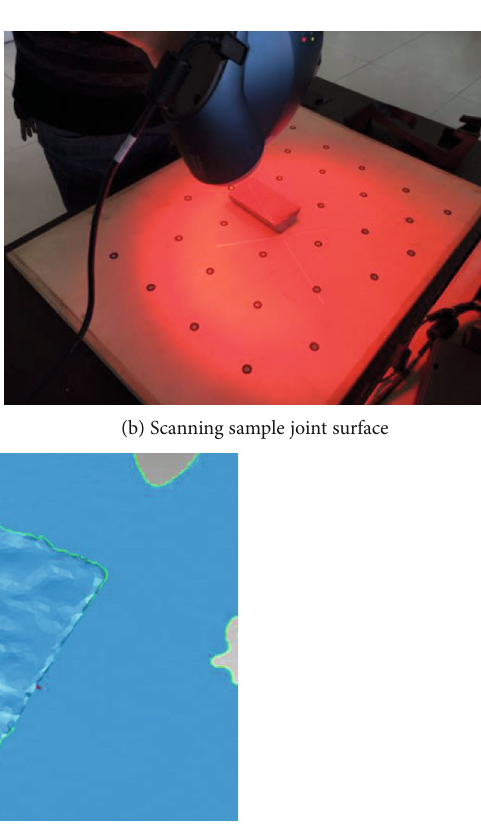
Figure 3: 3D scanning of joint